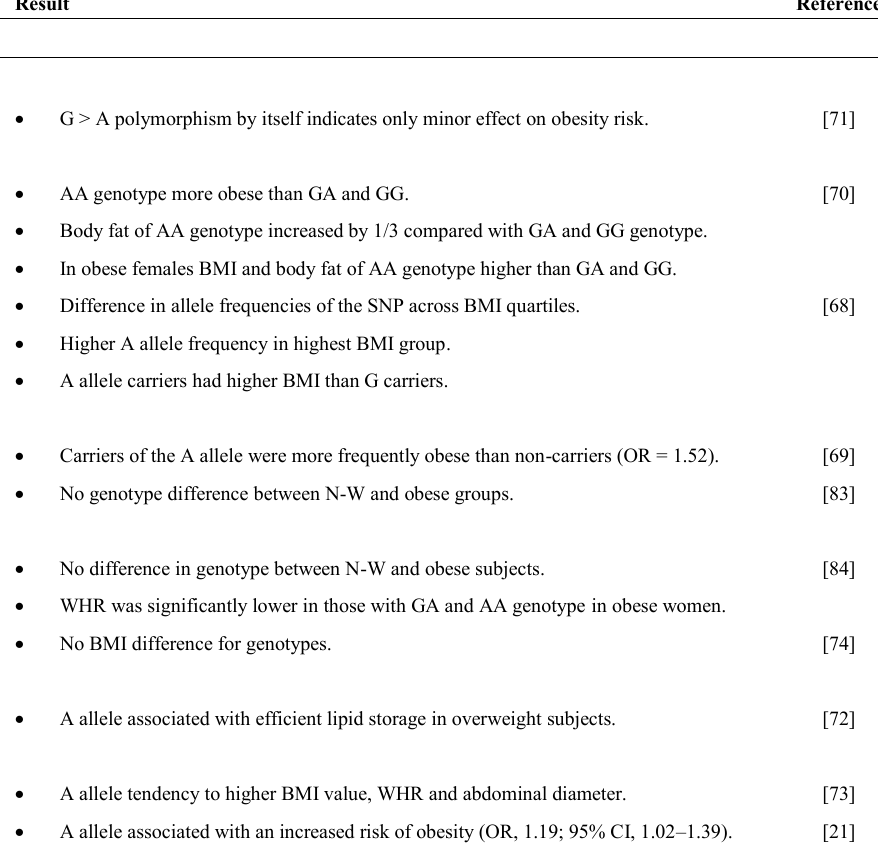
Table 2. Studies investigating associations between TNFA and IL-6 single nucleotide polymorphisms and obesity and serum lipids. SNP Study cohort Genotype frequency Result